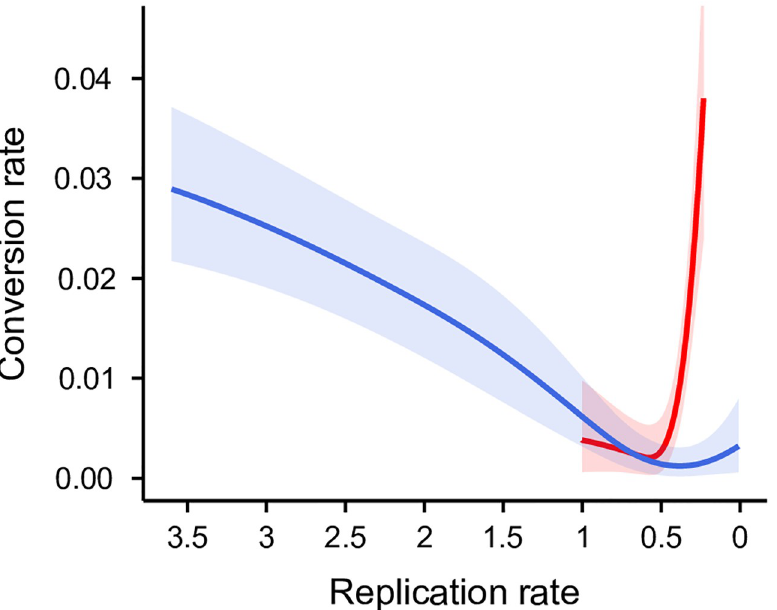
Fig 4. Other P . chabaudi genotypes adjust conversion in response changes in state. The densities of asexual stages were perturbed by drug treatment for genotype CWvir (blue) and by within-host competition with one or two other P . chabaudi genotypes for AS and AJ (combined, red). For these data we use replication rate as a proxy for state, calculated as the density of the asexual cohort making the conversion rate decision relative to the density of its asexual progeny. Replication rates are > 1 for expanding infections and < 1 in declining infections. Following [25, 66], conversion rate is estimated for each infection based on gametocyte, asexual and RBC dynamics. Solid lines and shaded areas are predictions ± SEM from generalised additive models for conversion as a function of replication